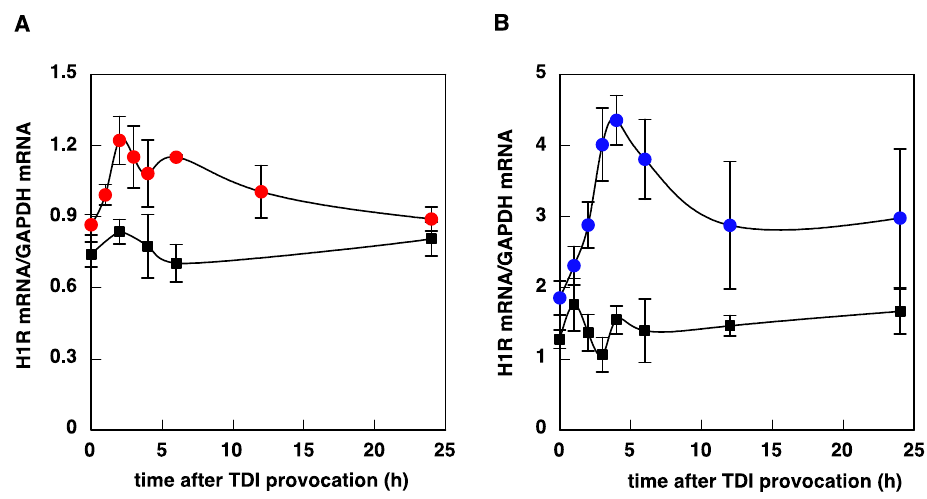
Figure 4. Time course of TDI-induced H1R mRNA upregulation in trigeminal ganglion ( A ) and nasal mucosa ( B ) of TDI-sensitized rats. At given time intervals after provocation with TDI, total RNA was isolated from trigeminal ganglion and nasal mucosa of TDI-sensitized and control rats. H1R mRNA was determined by real-time quantitative RT-PCR. Closed circles, TDI-sensitized rats; closed squares, control rats. Data are expressed as means ± SEM ( n =